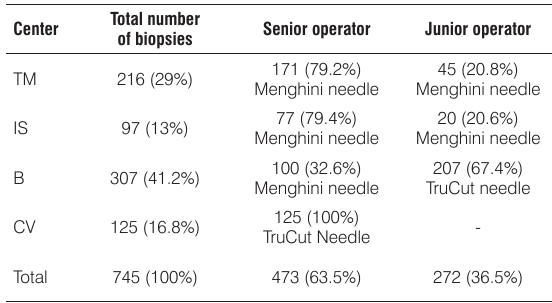
Table 1. Number of LBs, type of needle and operator’s